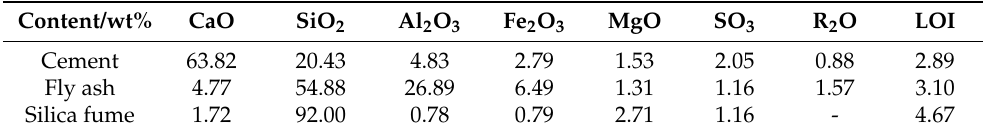
Table 1. Chemical compositions of the cement and admixture.